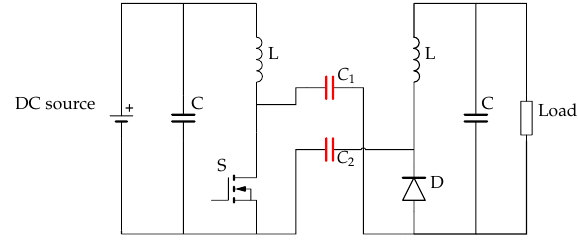
Figure 18. PWM based converter.